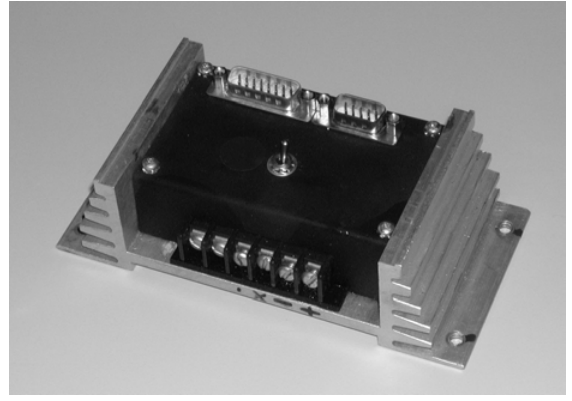
Fig 7. Actuator controller